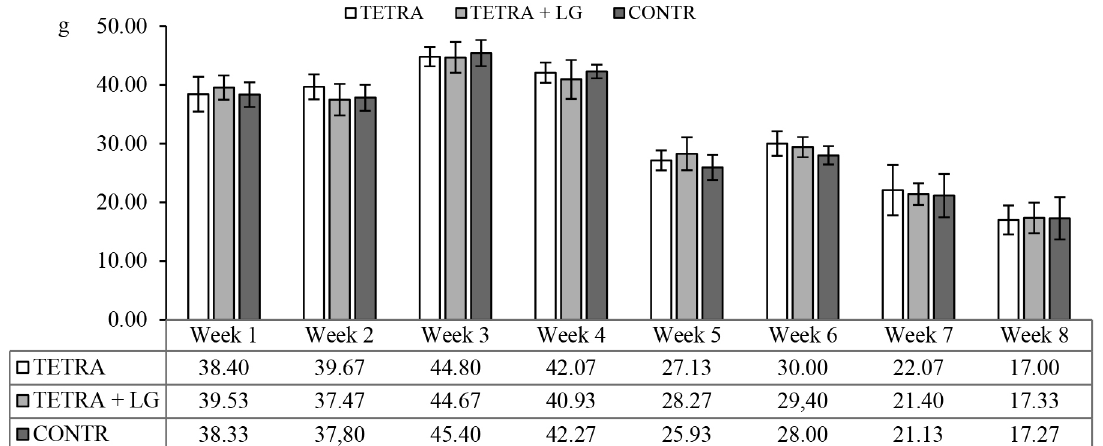
FIGURE 1 - Weekly average weight gain (g) and standard